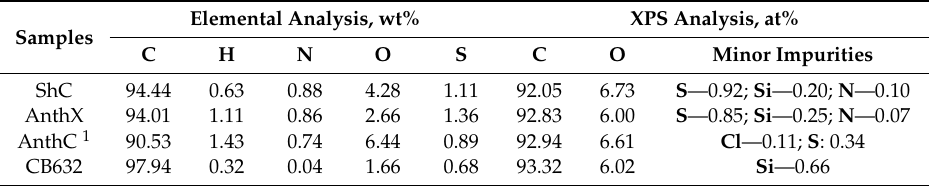
Table 2. Chemical content of amorphous carbons